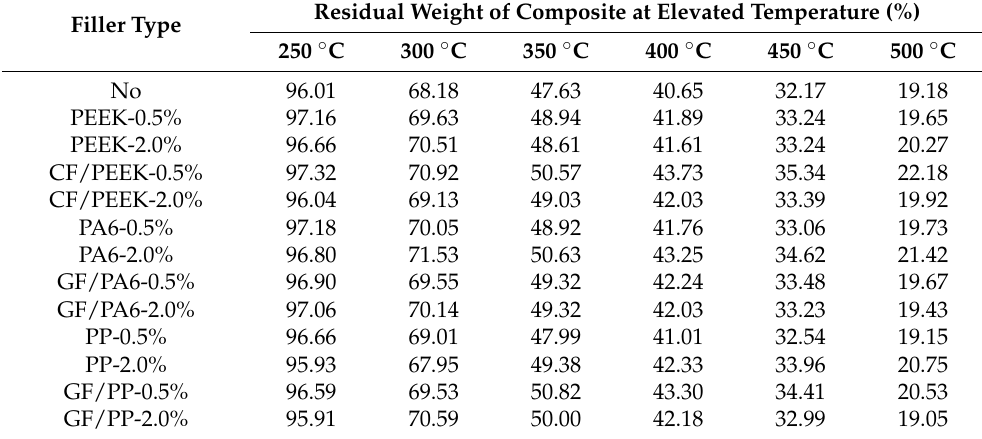
Table 2. Effects of thermoplastic resin and composite fillers on the thermal properties of Ts